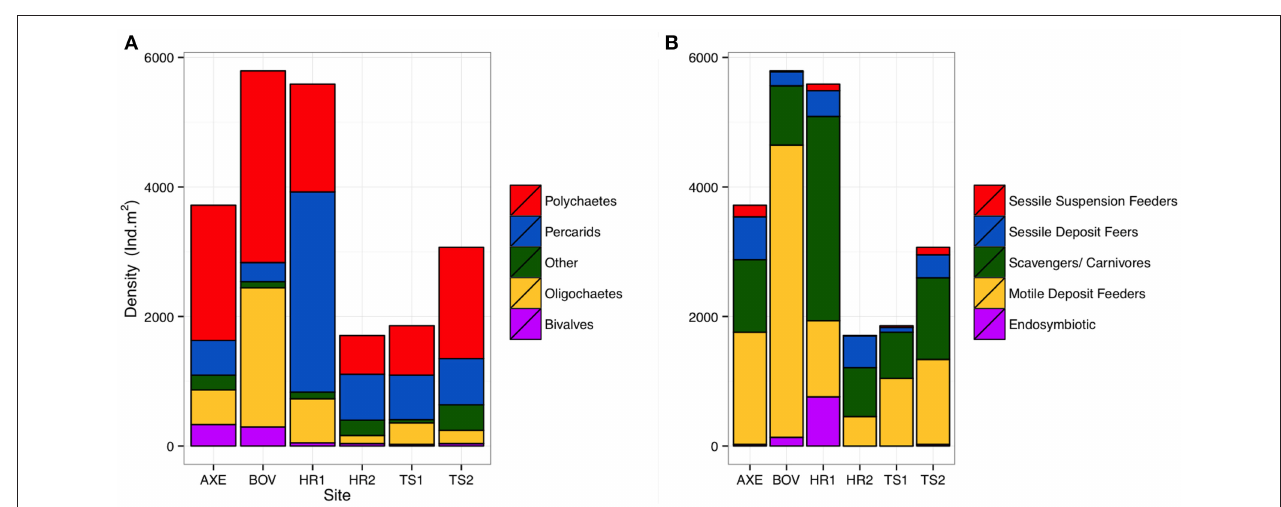
FIGURE 3 | Comparative density (ind. m − 2 ) of (A) major taxa and (B) functional groups by site for whole core data.